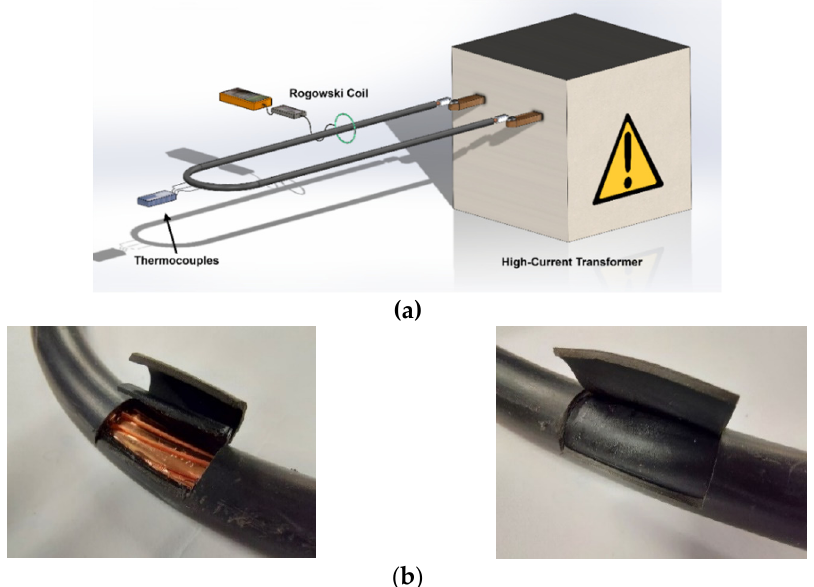
Figure 8. Experimental setup: ( a ) Transformer and cable loop used in the experiments. ( b ) Details of the insertions (conductor-insulation and insulation-jacket) made in the cable to place the thermocouples. To eliminate any hot spot or heat sink, the length of the cable was 4 m, which is in agreement with the recommendations found in different international standards